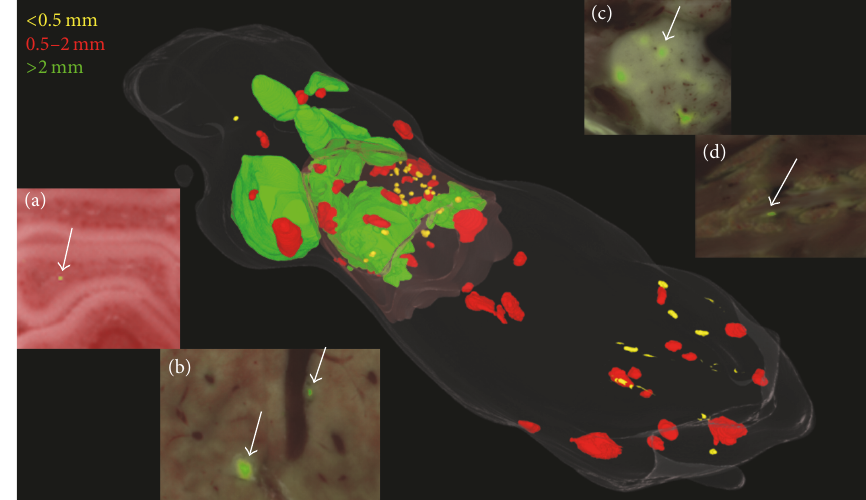
Figure 8: Distribution of metastases in the mouse tumor model. Segmented metastases are shown with volume rendering. Color coding of metastases is based on size as follows: < 0.5 mm (yellow), 0.5–2 mm (red), and > 2mm (green). There are 166 metastases in this mouse with 92 yellow, 63 red, and 11 green. Overlaid GFP and episcopic color images show tumor and anatomy. Examples of metastases are in (a) lungs, (b) vertebra, (c) liver, and (d)